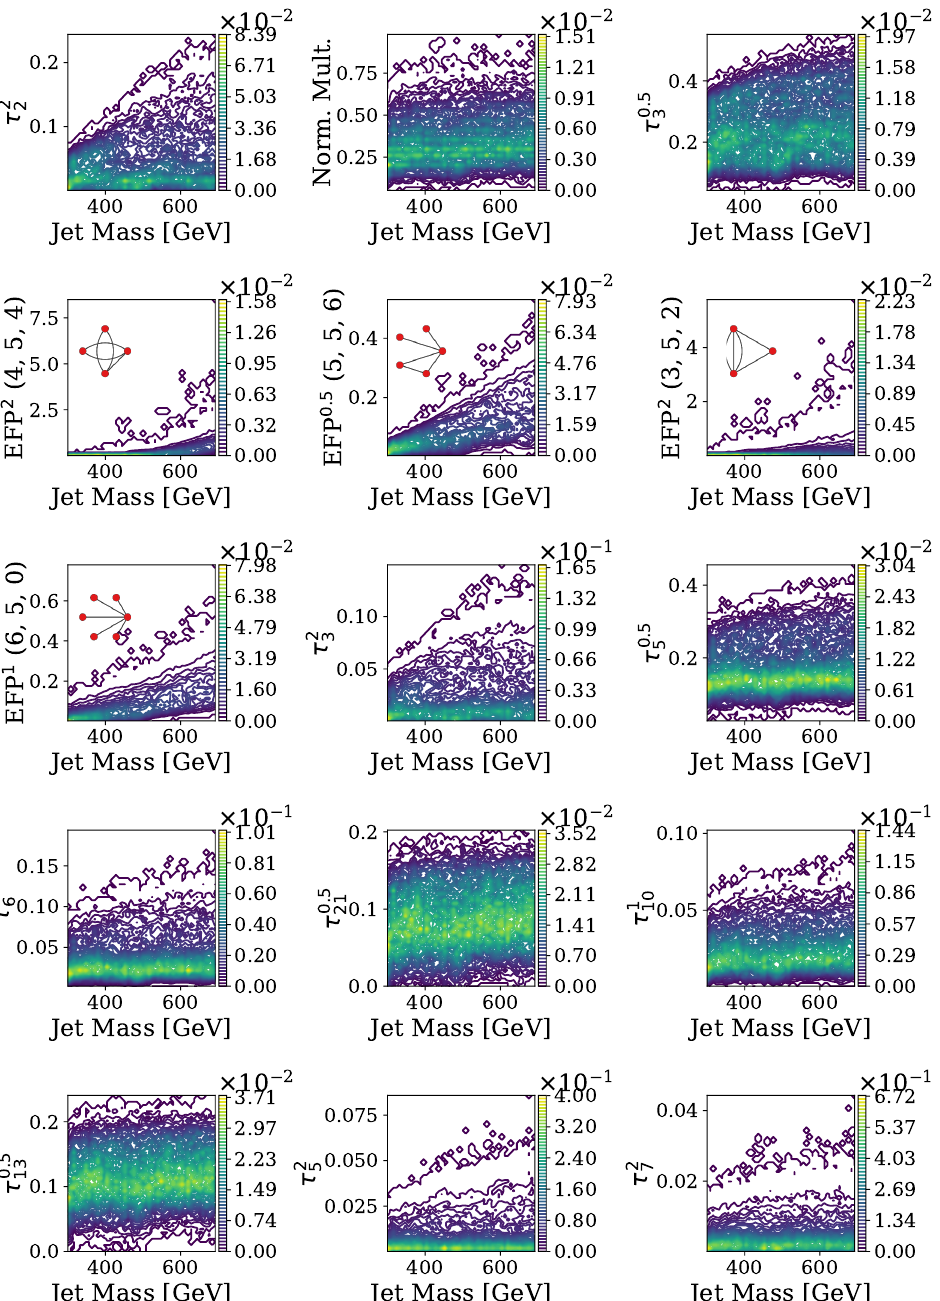
Figure 14 . Contour plots showing the probability density of the second half of the most important LASSO-selected observables versus the jet mass. The contour plots of the rest of the LASSO- selected observables are shown in figure